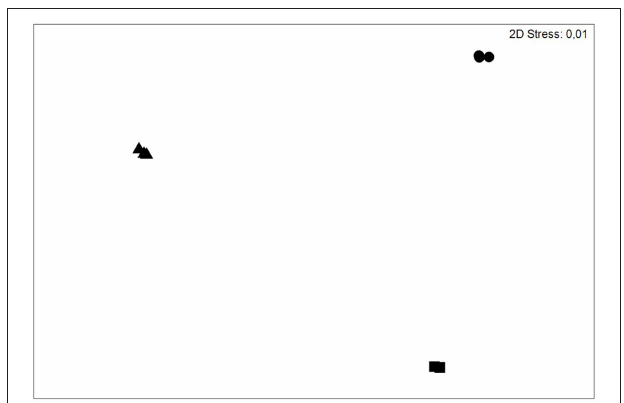
FIGURE 1 | Non-metric multi-dimensional scaling (nMDS) plot of the green alga Chlamydomonas klinobasis grown in continuous cultures grown at 15 ◦ C (triangles), 20 ◦ C (circles) and 25 ◦ C (squares) showing compositional distinctness. The relative non-transformed percentages of saturated fatty acids, mono-, di-, tri-, and tetra-unsaturated fatty acids were considered as fatty acid